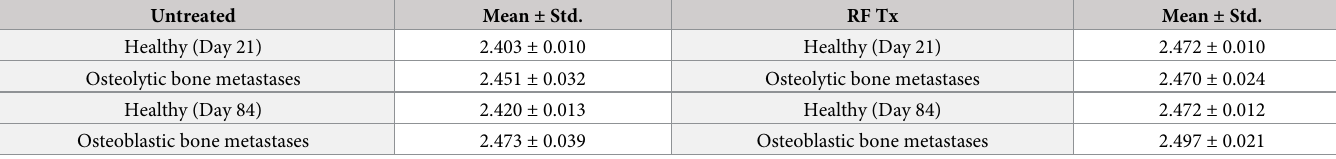
Second harmonic generation imaging on H&E stained histology slides derived susceptibility ratio values of untreated and treated femora of healthy and bone with metastases. Std.: standard